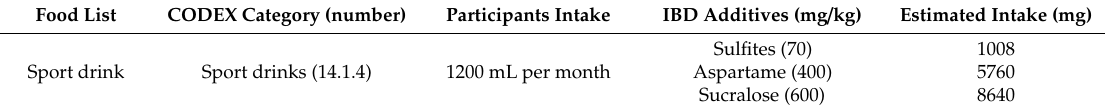
Table 6. Example of using part 2 questionnaire to estimate maximum food additives consumed.